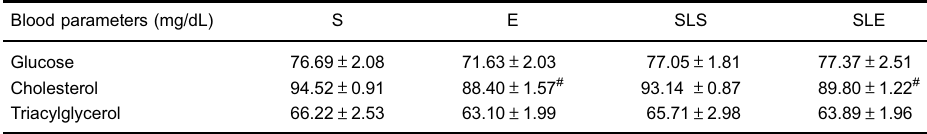
Table 1. Plasma concentration of glucose, total cholesterol, and triacylglycerol in the sedentary (S), exercise (E), small-litter sedentary (SLS), and small-litter exercise (SLE) groups.